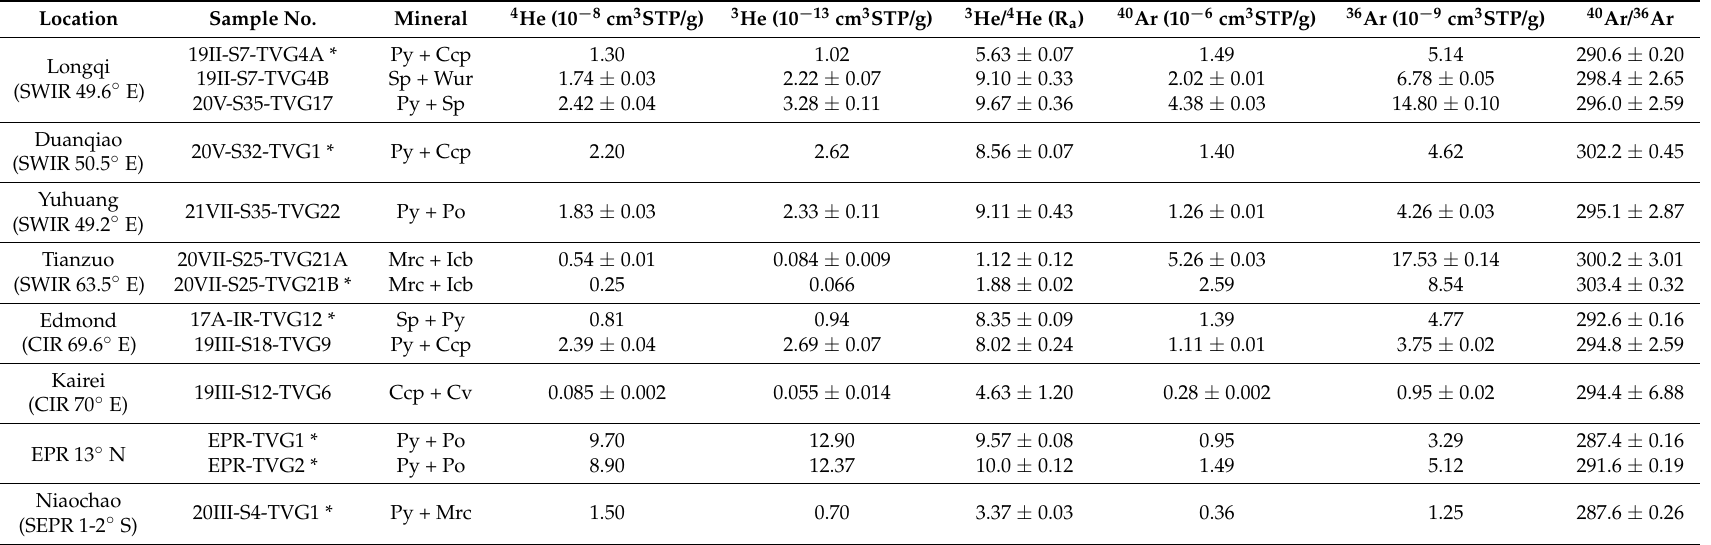
Table 2. He–Ar concentrations (cm 3 STP/g) and isotopic compositions of fluid inclusions hosted in seafloor polymetallic massive sulphides from the Mid-Ocean Ridge hydrothermal vent